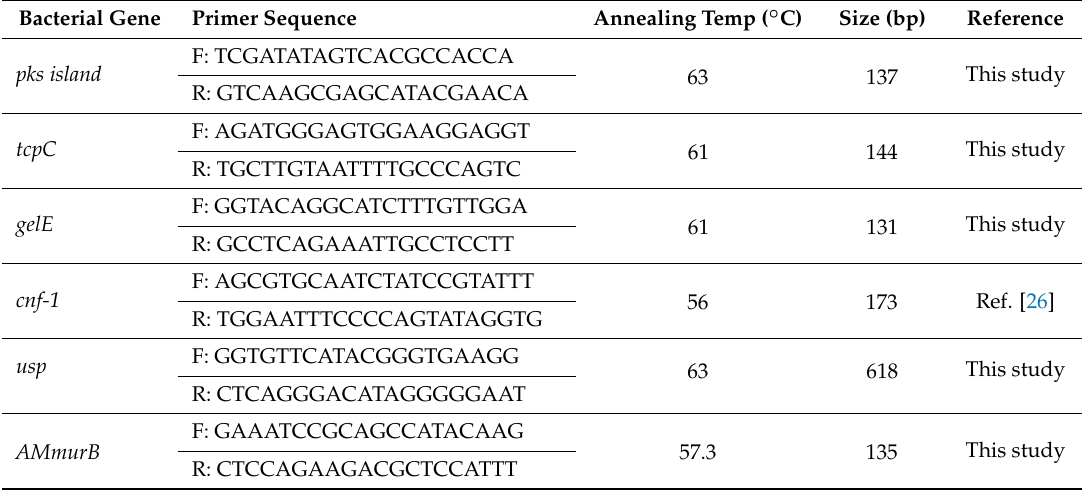
Table 3. Gut bacterial toxin gene primer sequences, annealing temperatures, and expected amplicon sizes for quantitative real-time PCR